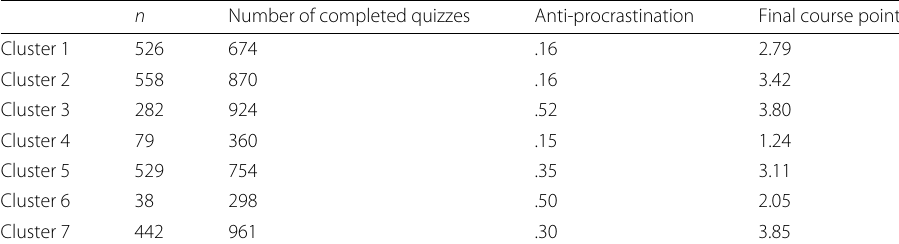
Table 5 Average of the clusters for learning pace